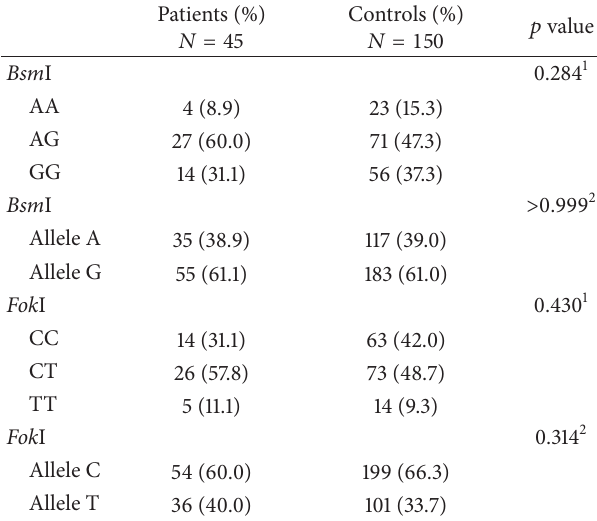
Table 3: Bsm I (A/G) and Fok I (C/T) genotypic and allelic frequen- cies in neurofibromatosis 1 patients and in unaffected controls.